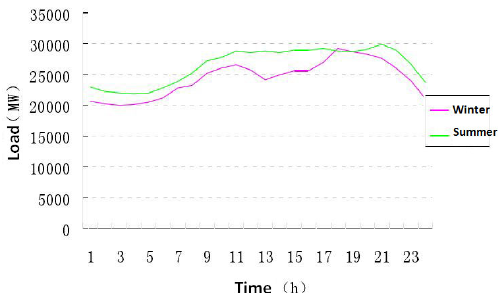
Figure 1. Typical daily load